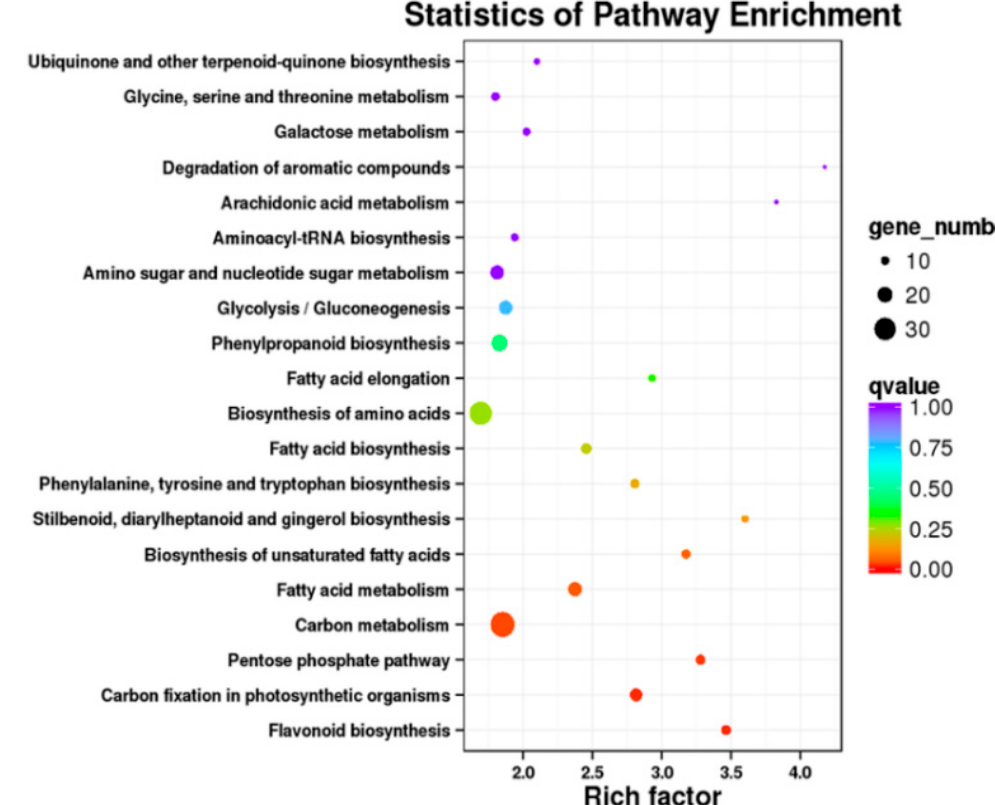
Figure 6. Kyoto Encyclopedia of Genes and Genomes (KEGG) pathway enrichment analysis of DEGs between OEJ-10 and the control. The X -axis represents enrichment factor; the Y -axis represents the pathway. The circles represent the KEGG pathways. The color of the circle represents the q -value. Lower q -values are shown in red.